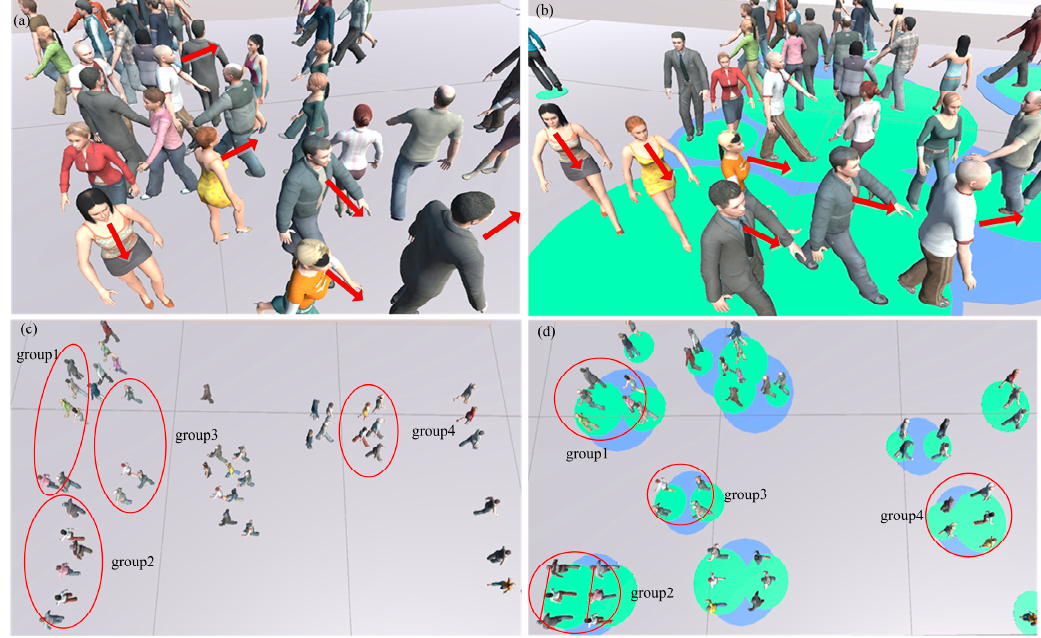
Figure 11. Qualitative comparisons between the extended social force model ( a and c ) and the SGFM ( b and d ). ( a , b ) Pedestrians’ directions of the same social group. ( c , d ) Structures of groups after avoiding.